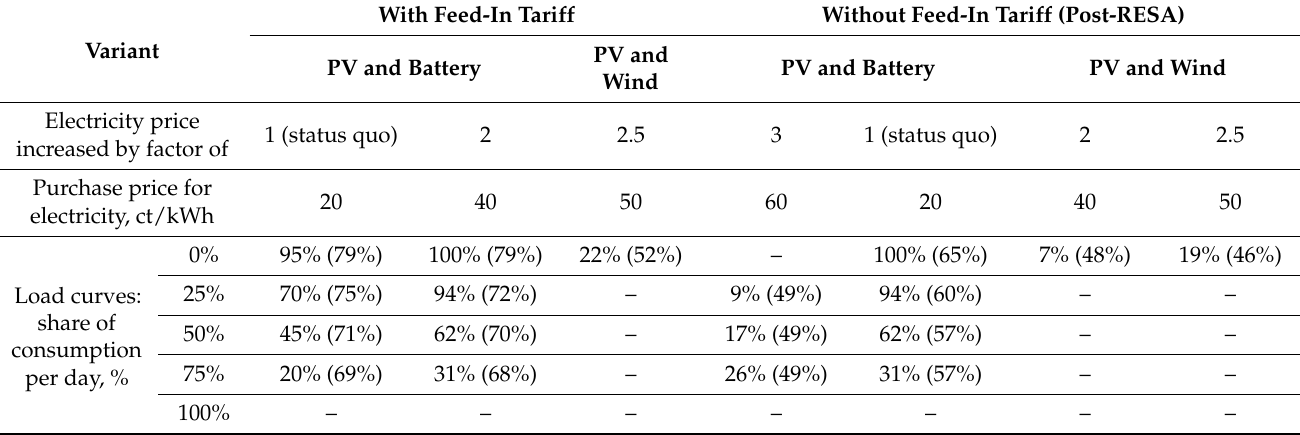
Table 11. Battery coverage in % of consumption (and utilization in